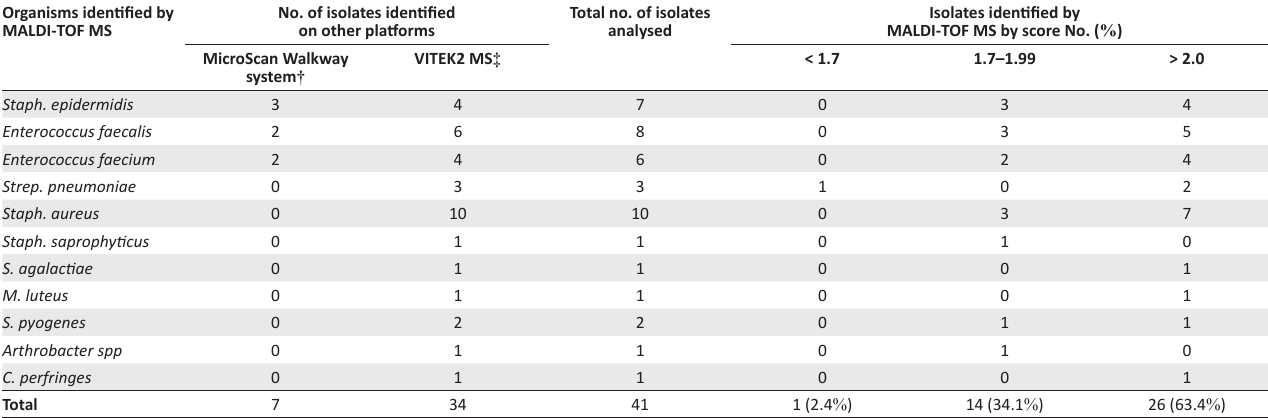
TABLE 2: Gram-positive bacterial isolates identified ( N = 41), Bloemfontein, South Africa, 15 July 2013 to 30 September 2013. Organisms identified by MALDI-TOF